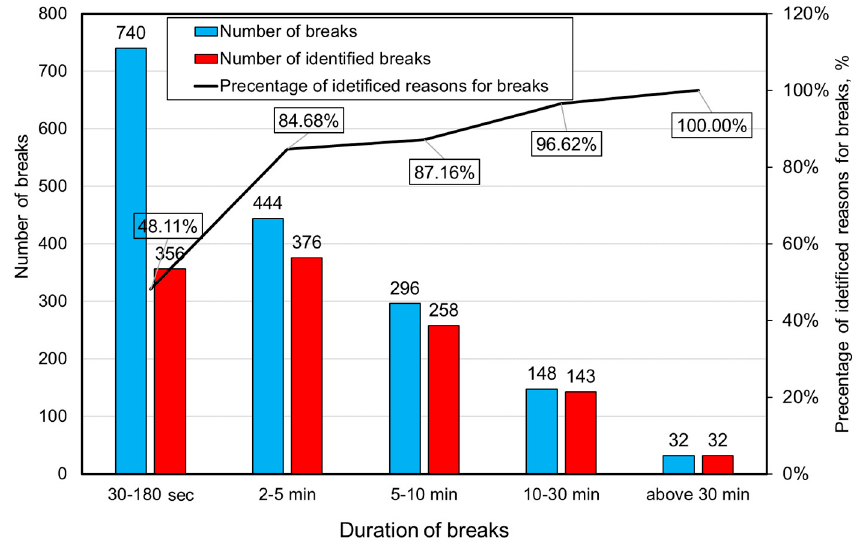
Figure 10. Summary of the number of identified breaks in the shearer’s work for particular time categories.